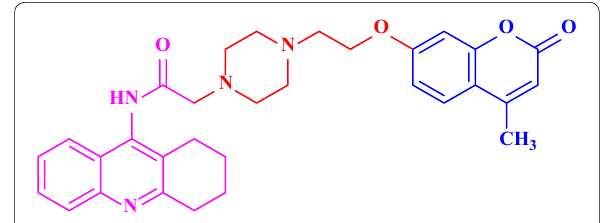
Fig. 79 Molecular structure of compound C92